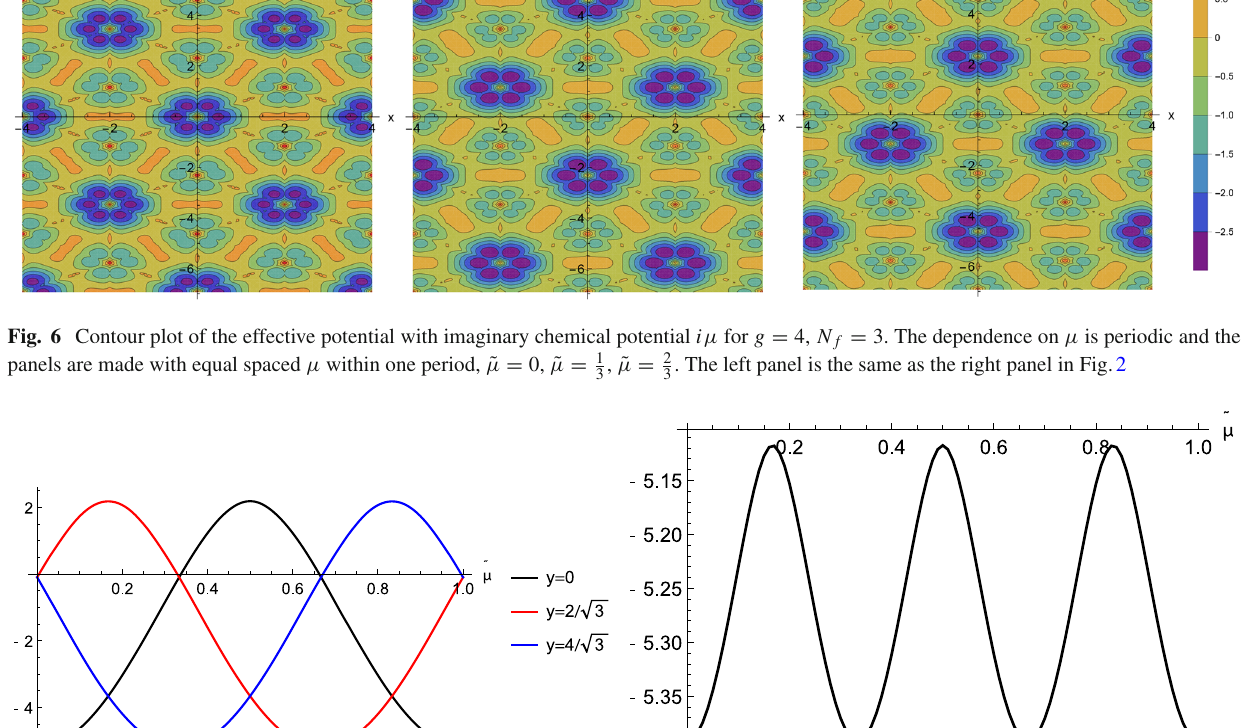
Fig. 7 The depths of three consecutive minima with g = 0, N f = 3 and x = 0 shown in Fig.6 as function of imaginary chemical potential ˜ μ (left panel) and their average (right panel)